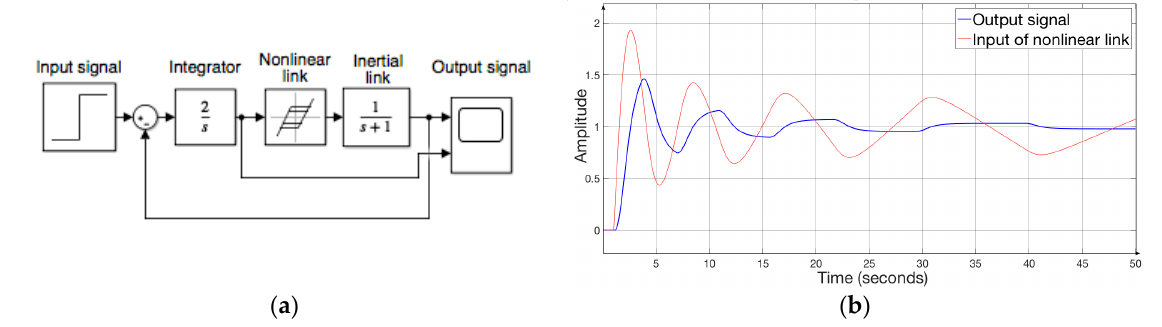
Figure 11. Diagram of a model with reduced gain nonlinearity( a ) and simulation result ( b ).